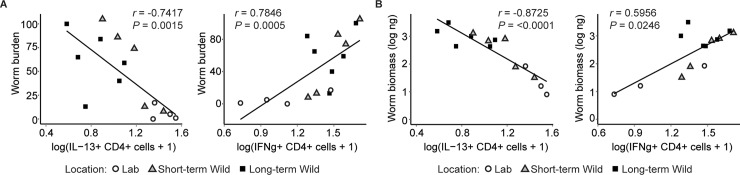
High worm burdens and worm biomass are associated with decreased proportions of Th2 and increased proportions of Th1 cells in LPMCs of Trichuris muris–infected mice.(A) A Spearman’s correlation was performed between worm burden and the proportion of CD4+ cells that are producing IL-13 and IFNγ from LPMCs of infected mice in the laboratory and outdoor enclosure at 3 weeks p.i. (B) A Spearman’s correlation was performed between worm biomass and the proportion of CD4+ cells that are producing IL-13 and IFNγ from LPMCs of infected mice in the laboratory and outdoor enclosure at 3 weeks p.i. Data on cytokine-positive lamina propria cells were log(x+1) transformed to meet assumptions of analysis. These correlations were all significant (P < 0.05) with P values and r values shown on graphs. White circles = Lab; gray triangles = Short-term Wild; black squares = Long-term Wild. https://doi.org/10.5061/dryad.h9g697r. IFNγ, interferon-gamma; IL, interleukin; LPMC, lamina propria mononuclear cell; p.i., postinfection; Th1, type 1; Th2, type 2.